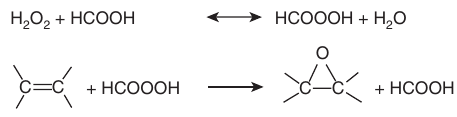
Figure 4 Multi-criteria outranking of different methods for catalyst plate treatment after use according to their environmental and cost efficiency.